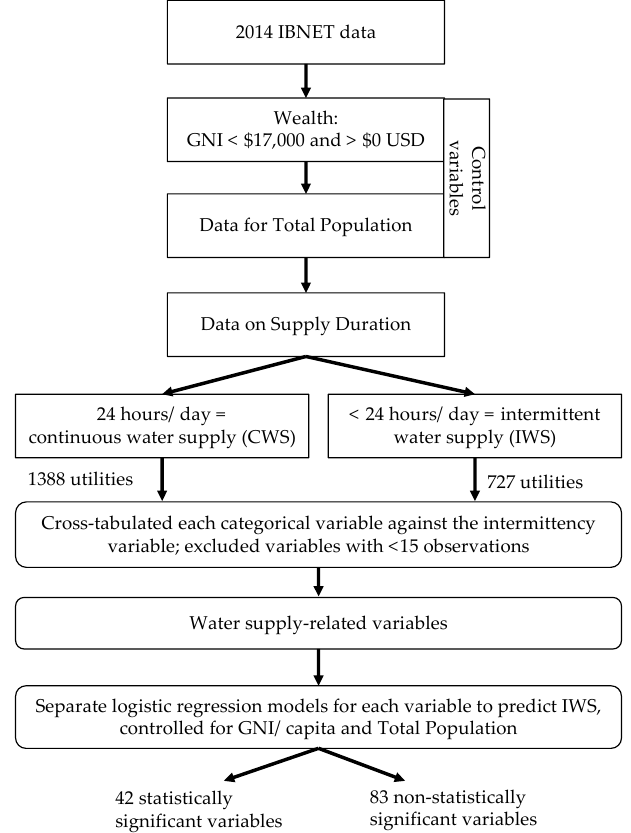
Figure 2. Flow chart describing methods, including selecting utilities and variables for analysis.